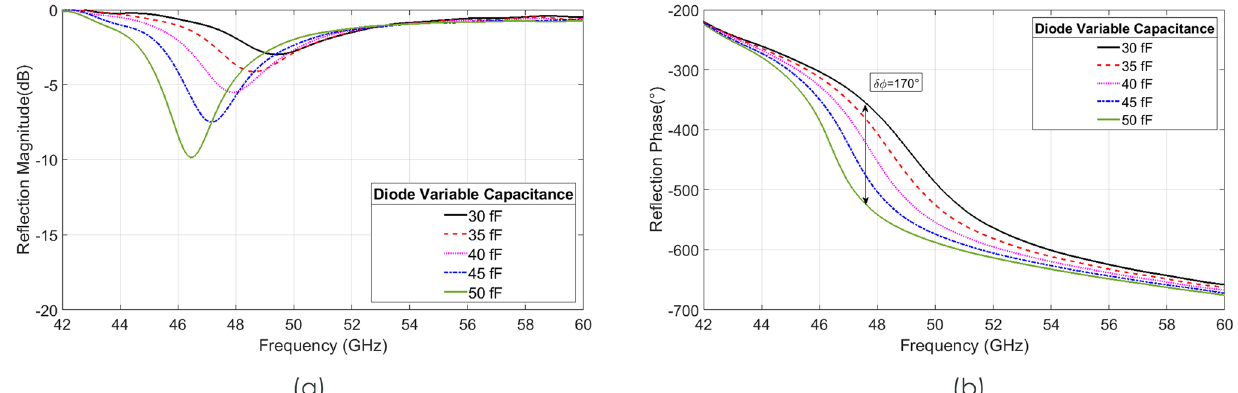
Figure 4. Simulation results of the isolated unit cell inside a waveguide ( a ) Reflection magnitude simulation results with varying the junction capacitance. ( b ) Reflection phase simulation results of the unit cell with varying the junction capacitance.